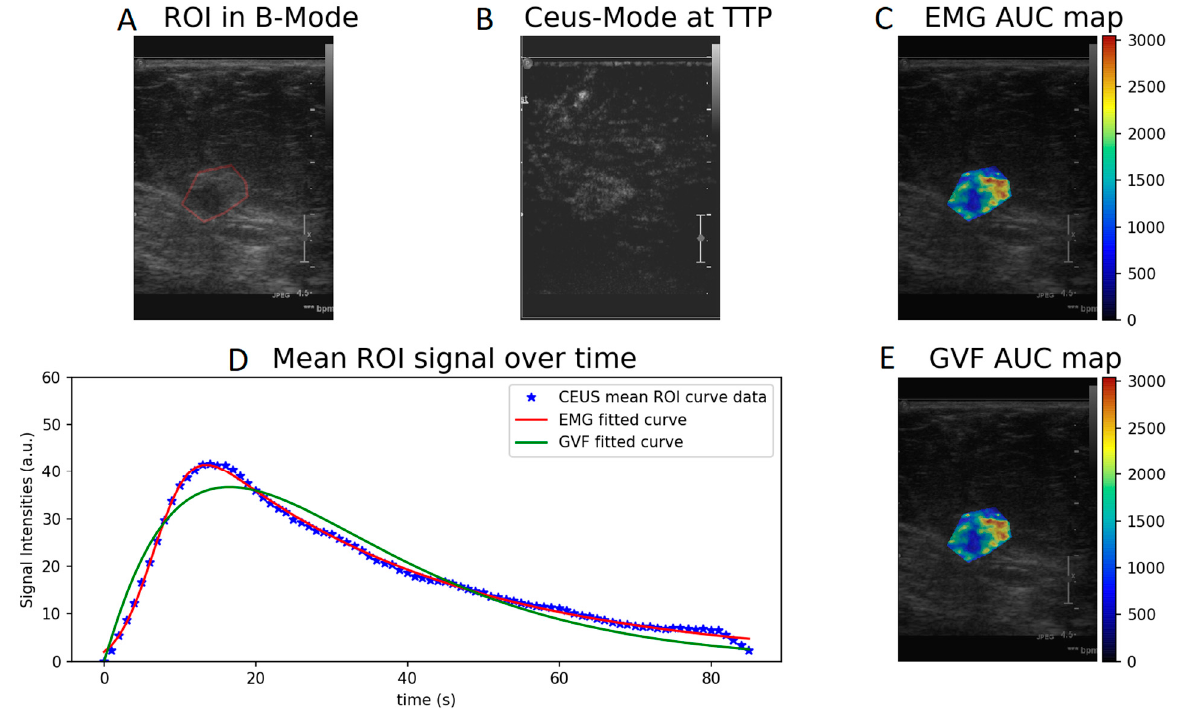
Figure 3. AUC parametric map calculated with EMG ( C ) and GVF ( E ) of a cancer patient. ( A ) ROI in B-mode, ( B ) CEUS mode at time to peak, and ( D ) EMG and GVF fitted to the mean ROI signal over time.